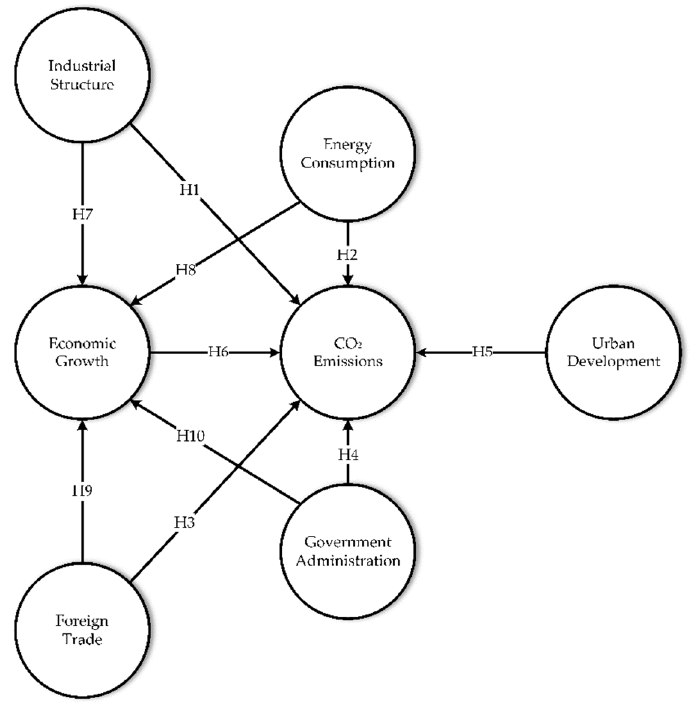
Figure 1. Proposed conceptual model.